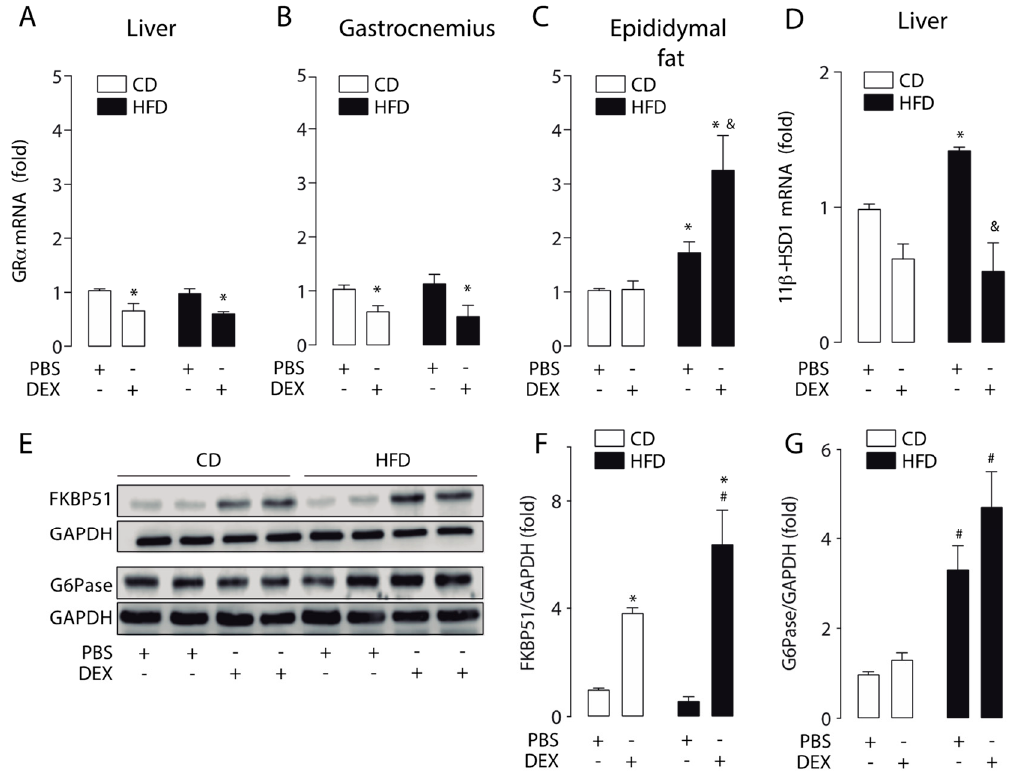
Figure 3. A high-fat diet increased the liver response to glucocorticoids. Glucocorticoid receptor α (GR α ) and 11 β -hydroxysteroid dehydrogenase type 1 (11 β -HSD1) mRNA levels were determined by qPCR in liver, gastrocnemius, and epididymal fat obtained from high-fat diet (HFD) or control diet (CD) mice treated with a dexamethasone injection (DEX; 2 mg / Kg i.p.) or phosphate-bu ff ered saline (PBS). FK506-binding protein 51 (FKBP51) and glucose-6-phosphatase (G6Pase) protein levels were assessed by Western blotting. Glyceraldehyde-3-phosphate dehydrogenase (GAPDH) was used as a loading control. ( A ) GR α mRNA expression in the liver. ( B ) GR α mRNA expression in the gastrocnemius. ( C ) GR α mRNA expression in epididymal fat. ( D ) 11 β -HSD1 mRNA expression in the liver. ( E ) Representative Western blot image. ( F ) Liver FKBP51 protein levels. ( G ) Liver G6Pase protein levels. n = 6 mice per condition. Two-way analysis of variance (ANOVA) was conducted, followed by Tukey’s post hoc test. * p < 0.05 vs. CD + PBS, # p < 0.05 vs. CD + DEX, & p < 0.05 vs. HFD + PBS. Values are expressed as mean ± standard error of mean.